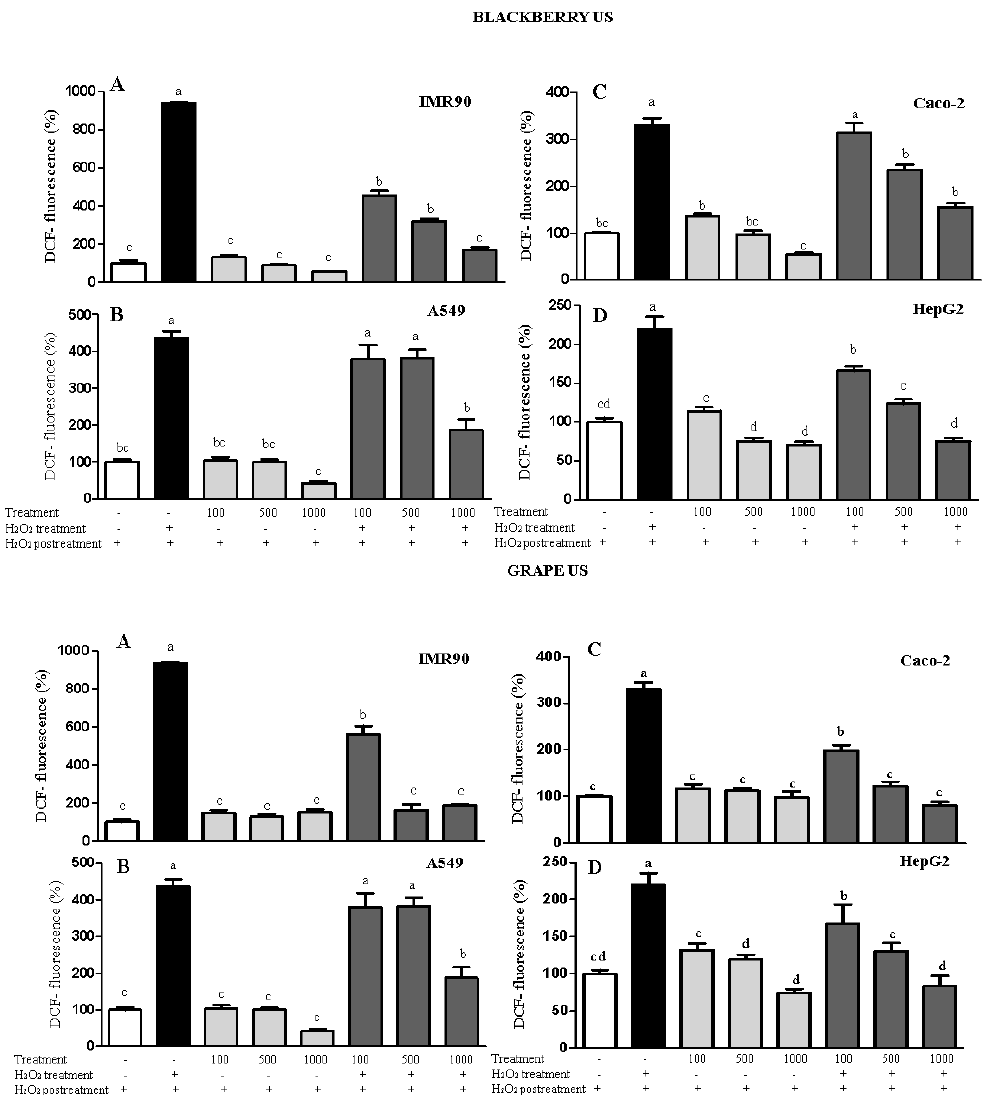
Figure 2. Results of the measurement of intracellular ROS in IMR90 ( A ), A549 ( B ), Caco-2 ( C ), and HepG2 ( D ) cells via spectrofluorimetry. Treatment = non-polar blackberry and grape seed extracts at 100 – 1000 μg /mL. Different letters comparing the treatments represent statistically different results at p < 0.05.